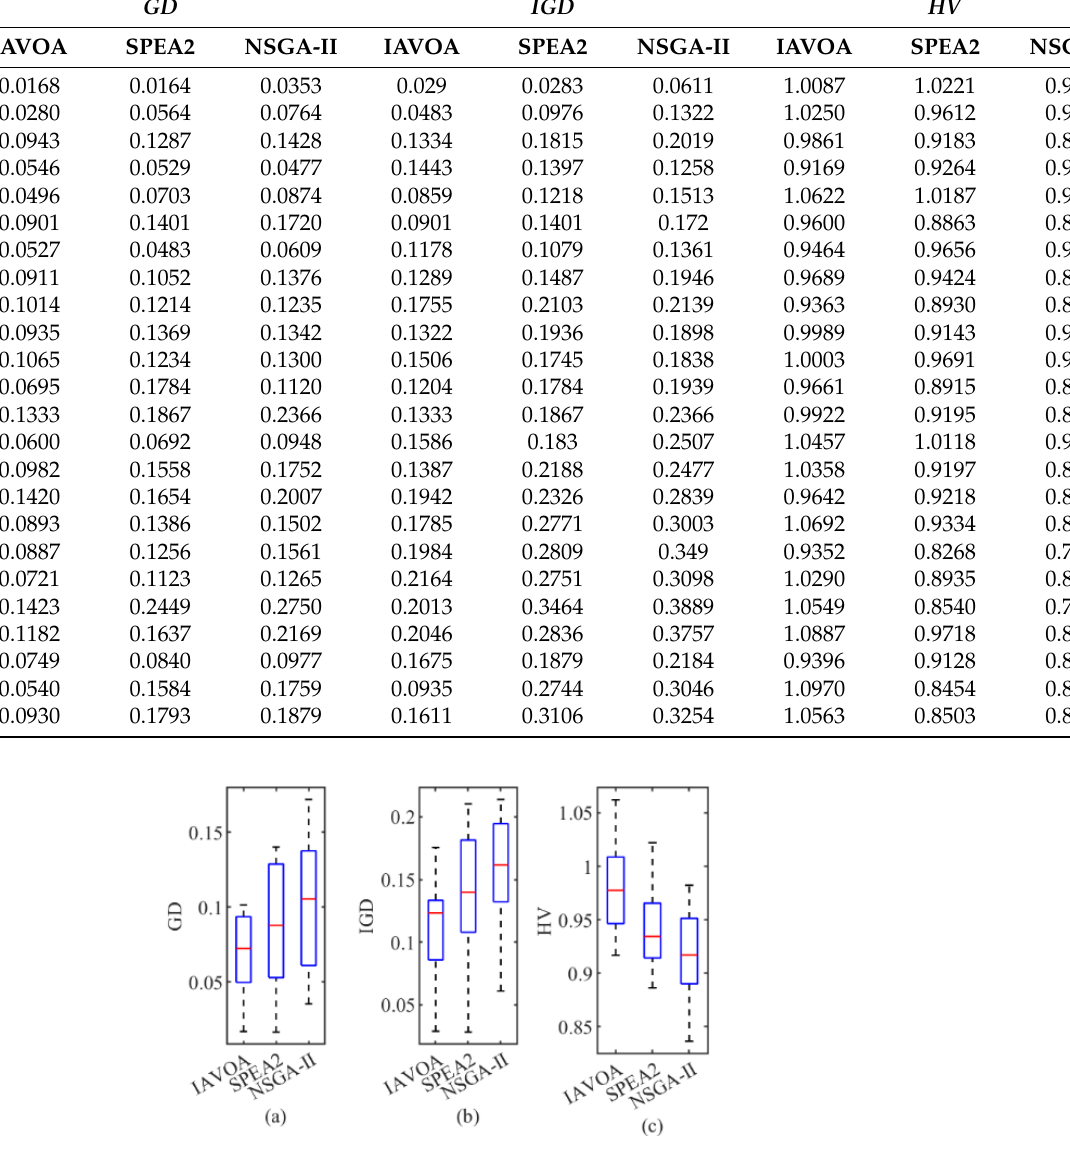
Table 6. Performance metric values of the three algorithms.